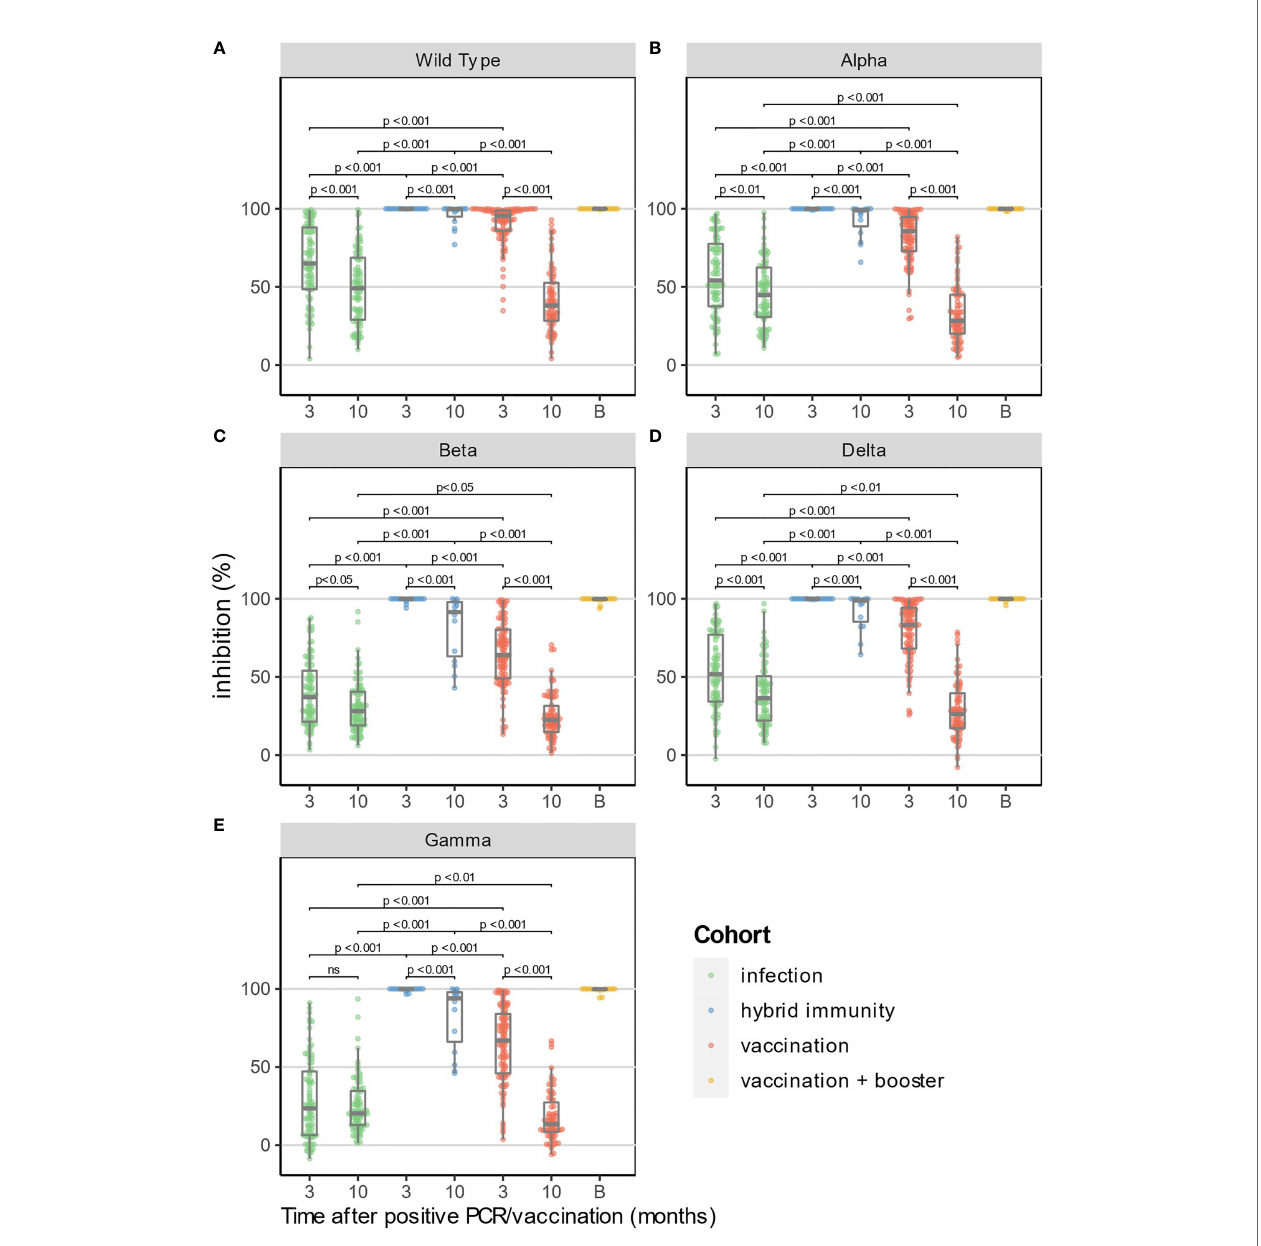
FIGURE 3 | Surrogate neutralizing antibody levels (% inhibition) at 3 and 10 months for WT and 4 VOC (A – E) . In addition, the results at 10 months of HCW who have received a booster dose before the 10-month time point are shown in yellow (excluded for statistical analysis). Median time after booster (shown as time point "B") was 21 days (IQR: 13.8-39.5